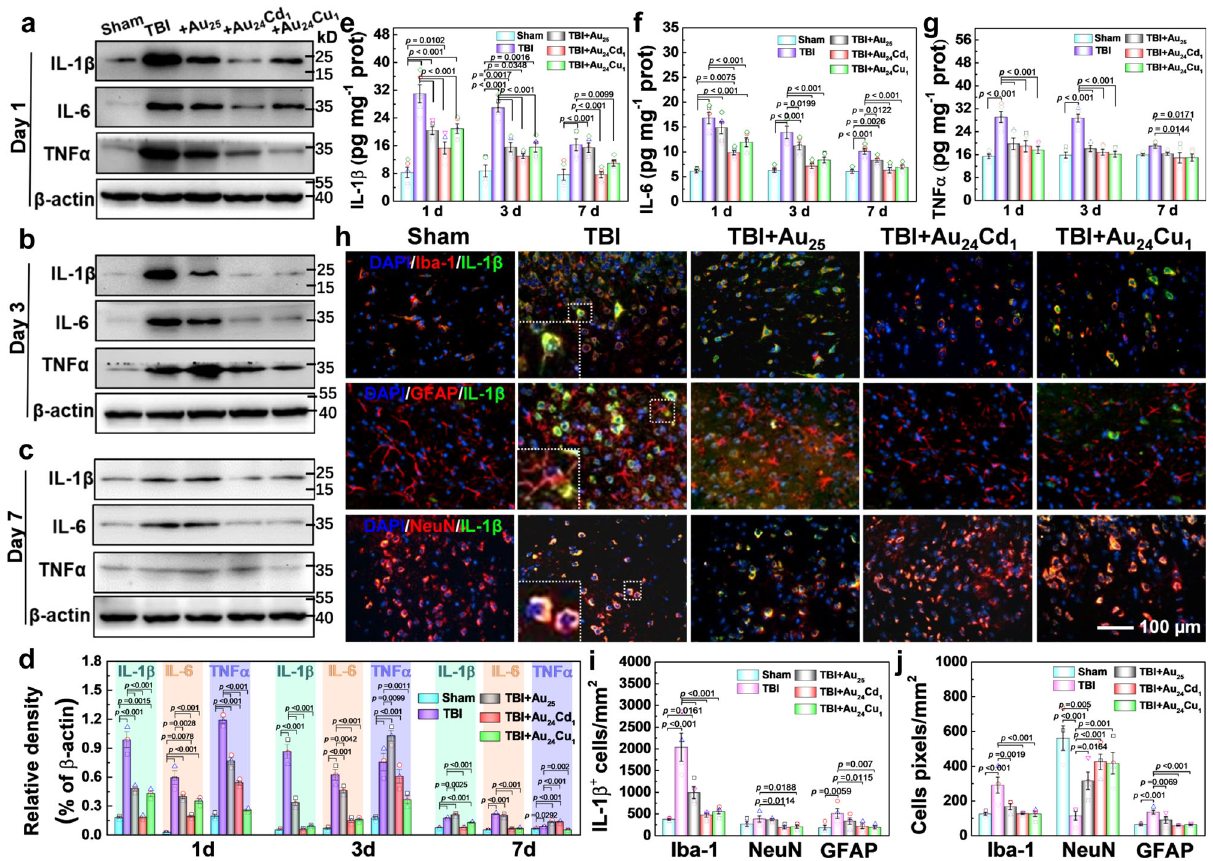
Fig. 6 In fl ammation levels in brain tissues after clusterzyme treatment. a – c Western blotting for IL-1 β , IL-6, and TNF α in the brain tissues 1, 3, and 7 days post TBI after treatment ( n = 3 per group), respectively. d Western blotting quantitative analysis of in fl ammatory factors at different time points ( n = 3 per group). All the samples were derived from the same experiment and blots were processed in parallel. Data are presented as mean ± SEM and compared with the Sham and TBI groups, analyzed by one-way ANOVA with two-sided LSD test (adjusted p values are shown). It can be seen that Au 24 Cd 1 can rapidly and signi fi cantly reduce the upregulated in fl ammatory cytokines of IL-1 β and IL-6 after brain injury, while Au 24 Cu 1 has a better ability to reduce the expression of TNF α . e – g ELISA quantitative analysis of IL-1 β , IL-6, and TNF α levels in brain tissues on days 1, 3, and 7 with or without clusterzymes treatment ( n = 5 per group), respectively. Data are presented as mean ± SEM and compared with the Sham and TBI groups, analyzed by one-way ANOVA with two-sided LSD test (adjusted p values are shown). h Immuno fl uorescence co-staining of IL-1 β and microglia (Iba-1), astrocytes (GFAP), or neurons (NeuN) in injured cortex 3 days post injury with or without clusterzyme treatment. Quantitative analysis of i the number of IL-1 β + expression in different positive cells and j the pixels density of Iba-1/NeuN/GFAP cells in the injured cortex with or without clusterzyme treatment ( n = 3 per group). Data are presented as mean ± SEM and compared with the Sham and TBI groups, analyzed by one-way ANOVA with two-sided LSD test (adjusted p values are shown). Experiments were repeated independently a – c twice and h three times with similar